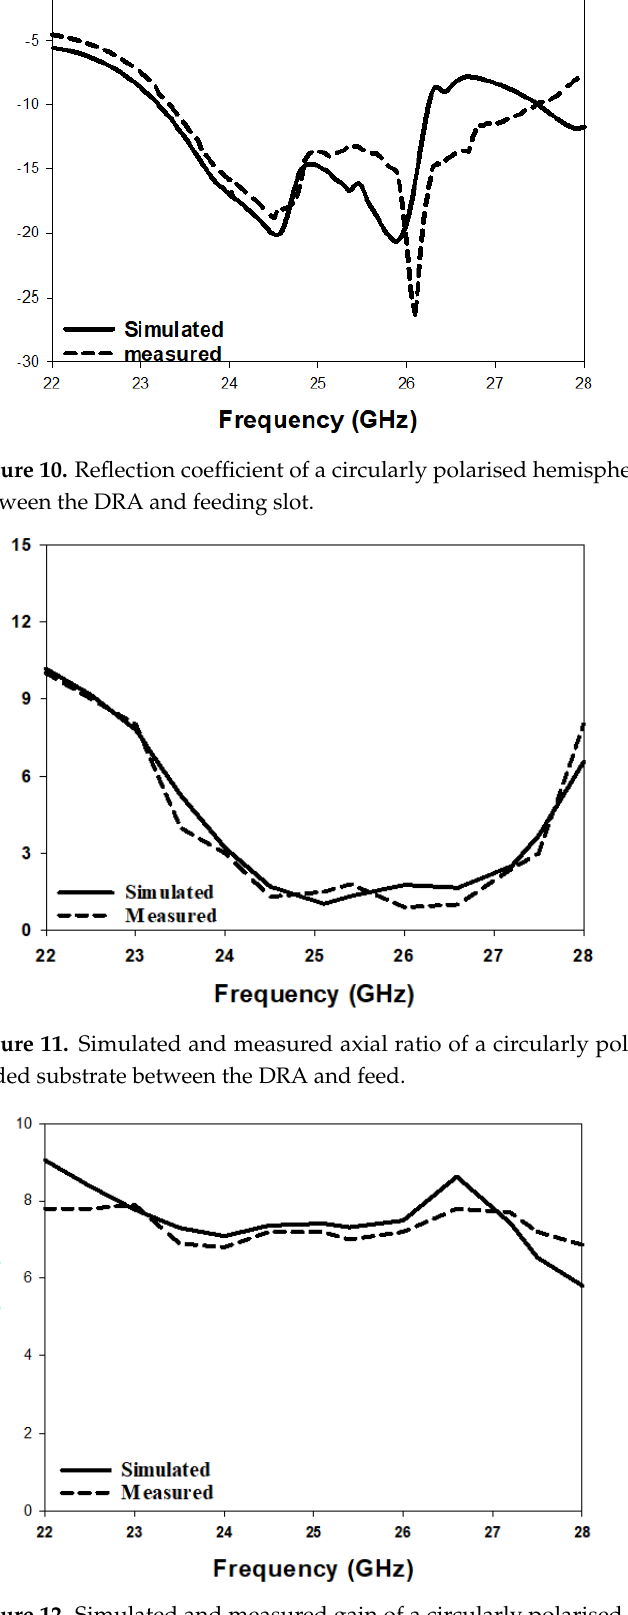
Figure 12. Simulated and measured gain of a circularly polarised hemispherical DRA with added substrate between the DRA and